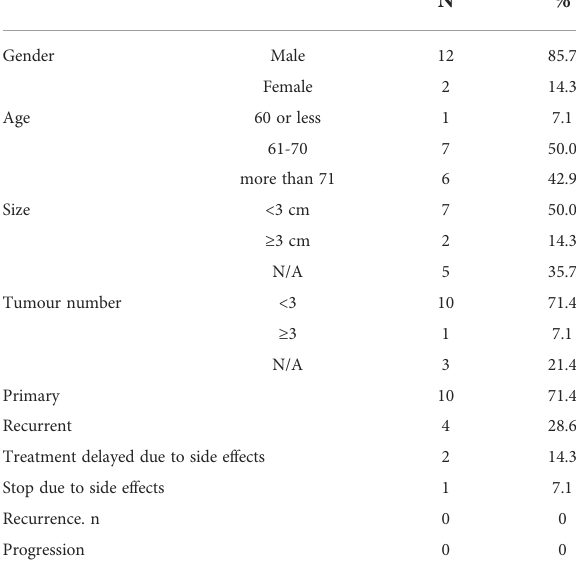
TABLE 1 Patient demographics and clinical